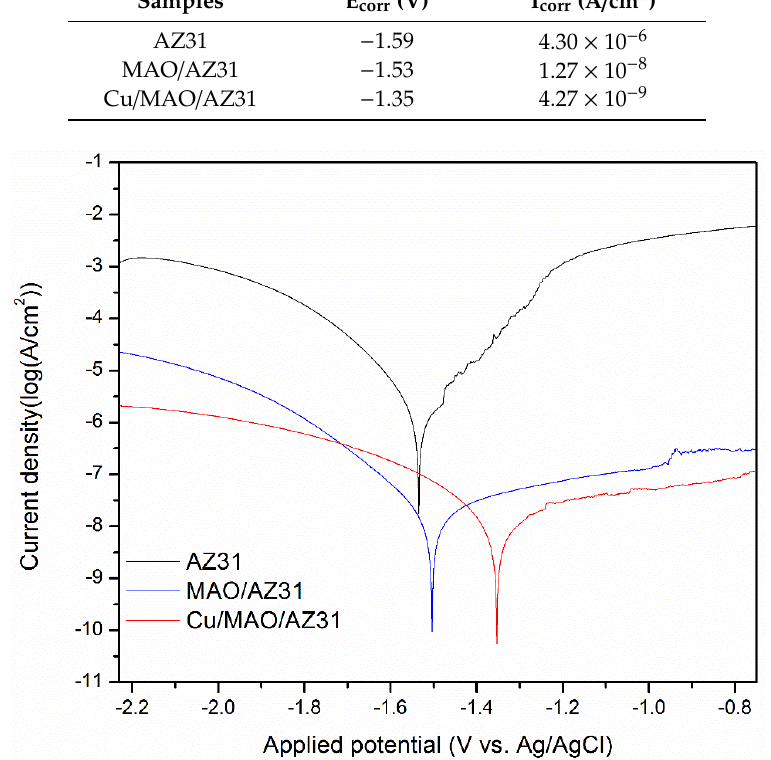
Figure 6. Typical potentiodynamic curves and resulting data of AZ31, MAO/AZ31, and Cu/MAO/AZ31 in a simulated body fluid (SBF) solution. Table 2. Parameters for the Tafel polarization method.